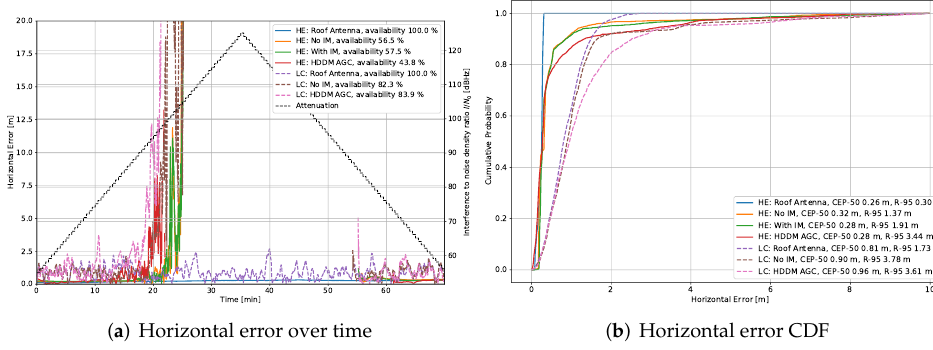
Figure A25. Interference #7: Filtered noise with 35MHz bandwidth.